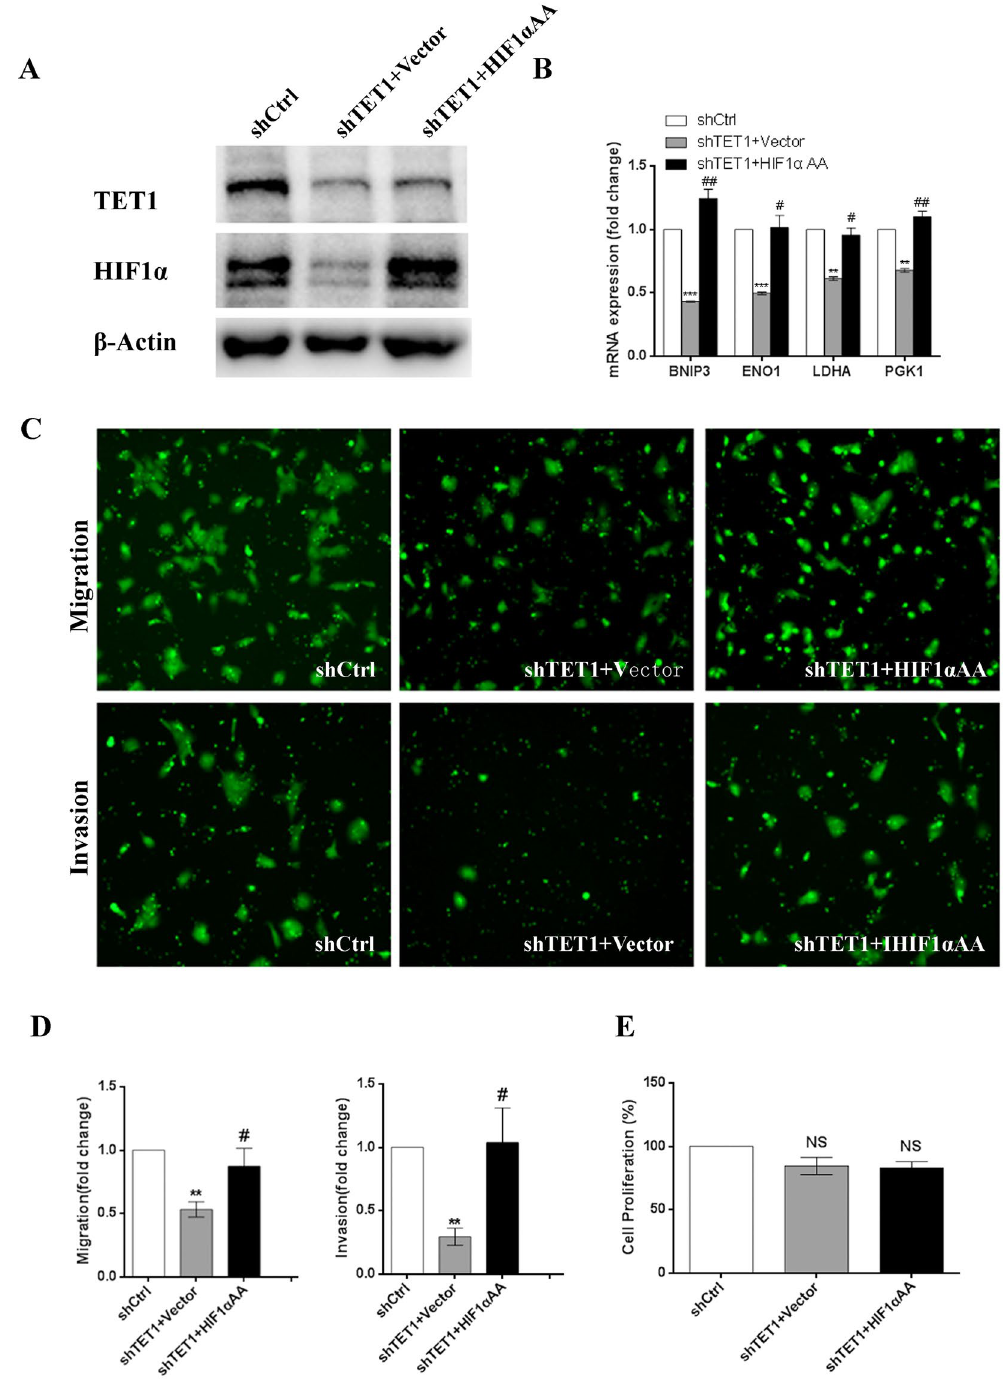
Figure-7. Increased HIF1 α expression reverses the inhibitory effect of TET1 knockdown on JEG3 cell migration and invasion following exposure to 3% O 2 . ( A ) The protein expression of HIF1 α in scramble control- and shTET1-transfected JEG3 cells transiently transfected with the vector or HIF1 α AA for 48 h. ( B ) The mRNA expression of ENO1, LDHA, PGK1 and BNIP3 in scramble control- and shTET1-transfected JEG3 cells transiently transfected with the vector or HIF1 α AA for 48 h. ( C , D ) The quantitative cell migration and invasion data are expressed as the fold change from the control of three independent experiments. ( ** P < 0.01, shCtrl vs. shTET1 + Vector; # P < 0.05, shTET1 + Vector vs. shTET1 + HIF1 α AA) ( E ) The proliferation capacity in scramble control- and shTET1-transfected JEG3 cells transiently transfected with the vector or HIF1 α AA for 48